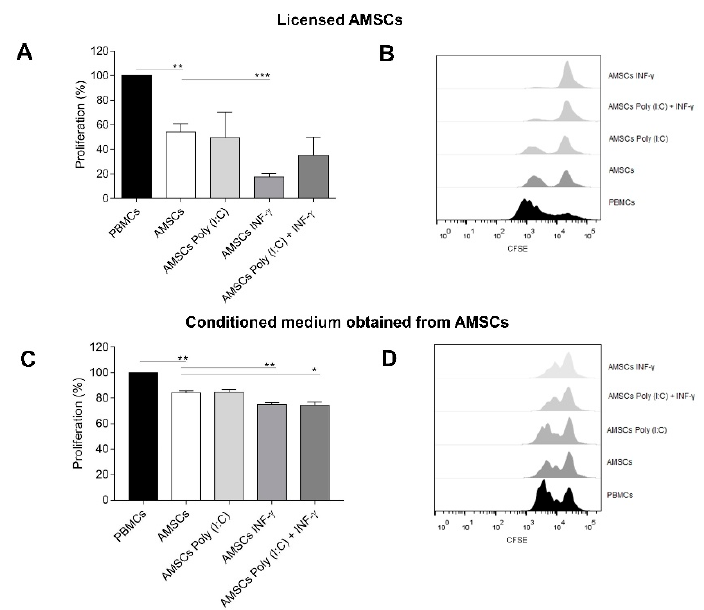
Figure 3. Immunosuppressive capacity of licensed AMSCs and their conditioned